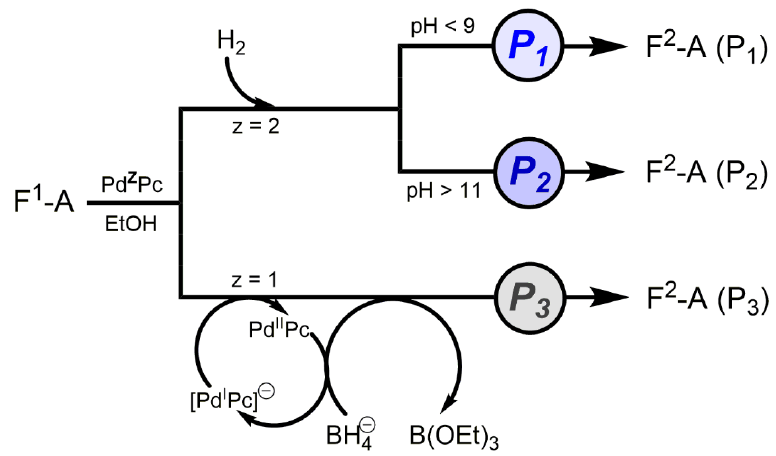
Scheme 3. Pd z Pc as hydrogenation catalyst with 3 switchable catalysis patterns P 1 –P 3 (Table 2) dependent on valence z in Pd z and basicity of reaction medium (Figure 4).